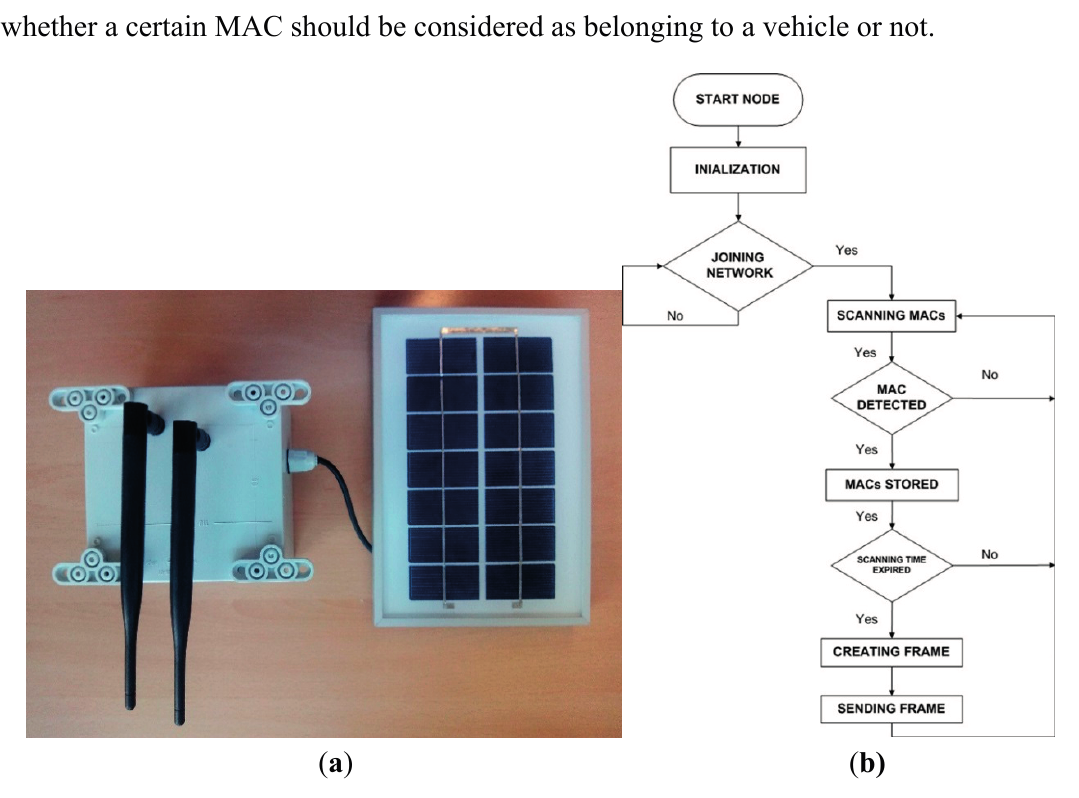
Figure 3. UIS BT node. ( a ) UIS BT node; ( b ) UIS BT node